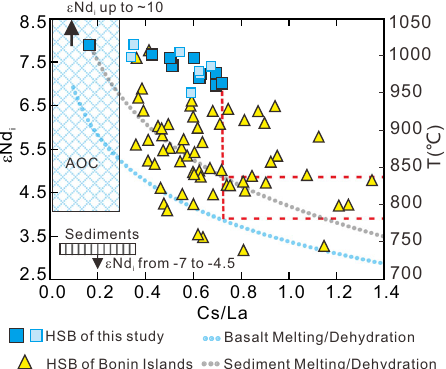
Fig. 6 Elemental ratios and neodymium isotopes characterize slab makeup and temperature during Expedition 352 high-silica boninite generation. ε Nd i (left y -axis) vs. Cs/La diagram for the Expedition 352 and Bonin Islands 60 high-silica boninite (HSB), Izu-Bonin trench sediments 38 and altered basalts 48,67 . The temperature (°C; right y -axis) versus Cs/La paths for sediment (light gray dotted line; calculated after Hermann and Rubatto 57 at 2.5 – 4.5 GPa) and basalt (light blue dotted line; calculated after Kessel et al. 68 at 4 GPa with Ocean Drilling Program Site 801 “ Super- Component ” as starting material) dehydration/melting are also plotted for comparison. The red dashed lines are used to estimate the slab dehydration/melting temperature during HSB generation of this study according their highest Cs/La ratio. AOC: altered oceanic